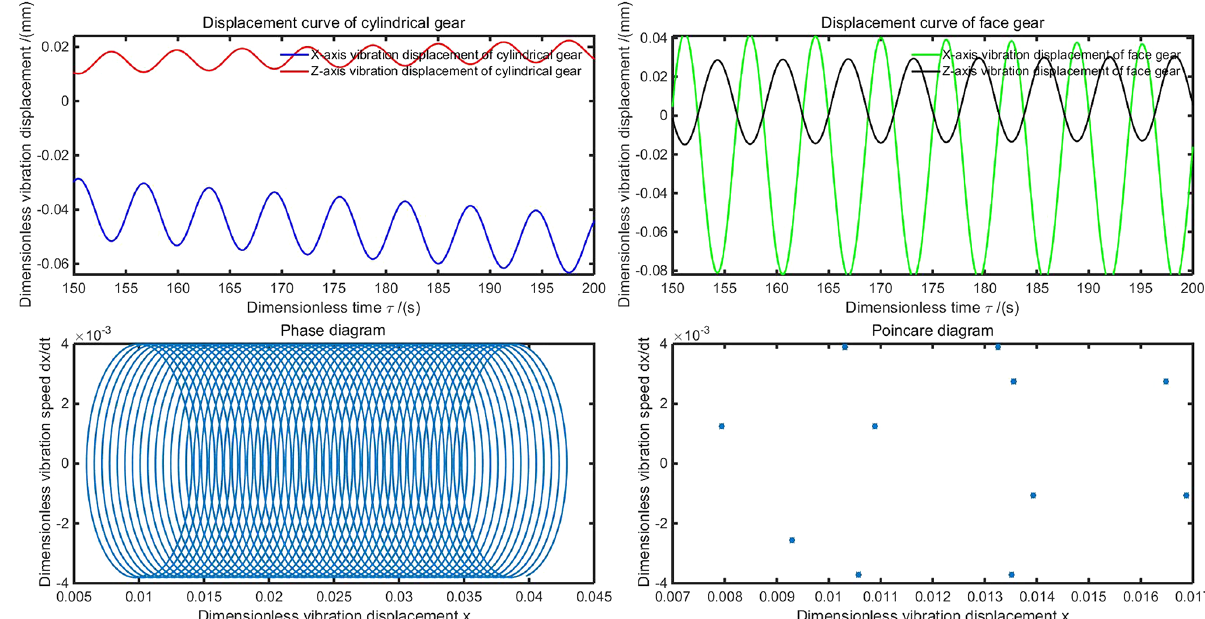
Figure 10. Displacement, phase, and Poincare diagrams of comprehensive meshing stiffness 9 . 852 × 7 Nm − 1